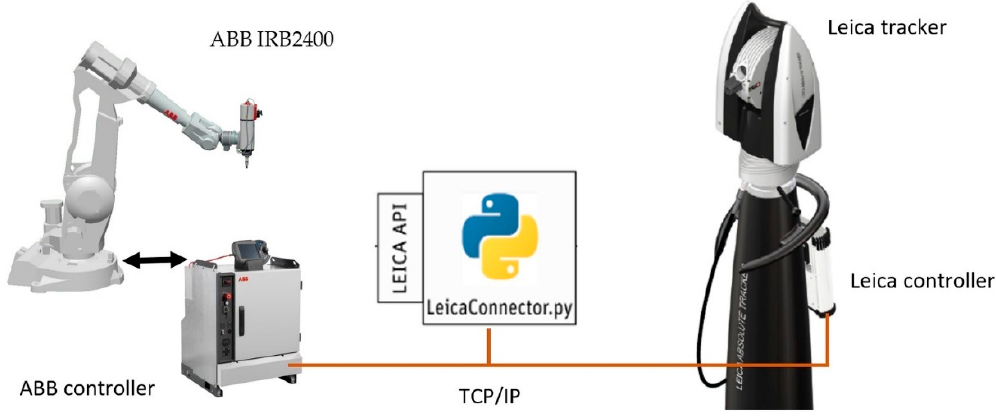
Figure 8. Communication diagram between Laser Tracker and Robot ABB.